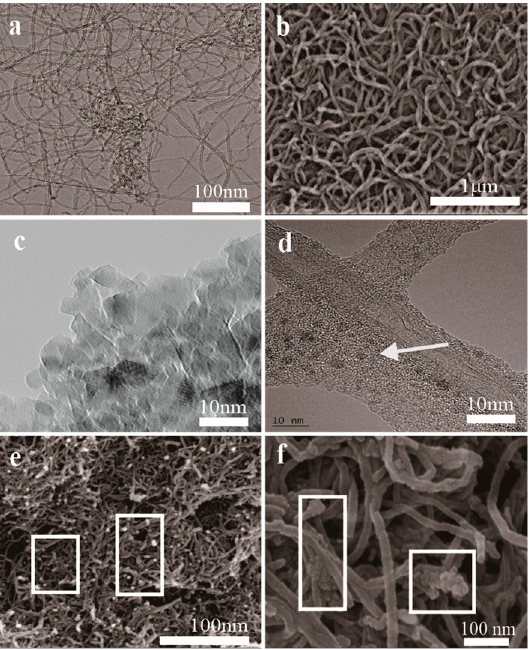
Figure 1. SEM ( b , e , f ) and TEM ( a , c , d ) images of magnetically functionalized CNTs: ( a ) original CNTs; ( b ) mCNTs-SH; ( c ) Fe 3 O 4 ; ( d ) mCNTs- g -Block; ( e ) mCNTs- g -PMMA; ( f ) mCNTs- g -Block.